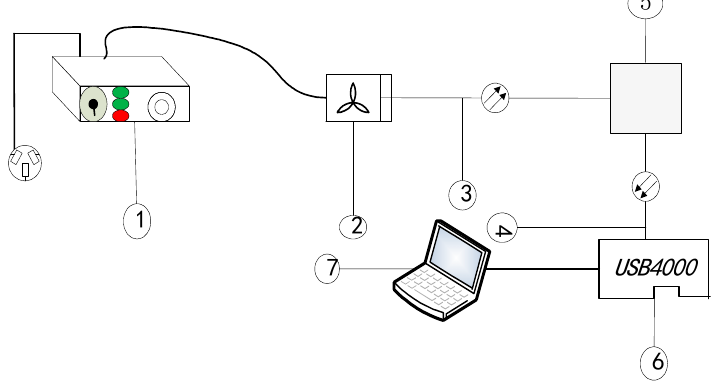
Figure 1. The laser-induced fluorescence detection system. 1—Adjustable power supply; 2—laser; 3—optical fiber X; 4—optical fiber Y; 5—detection platform; 6—spectrometer; 7—computer.